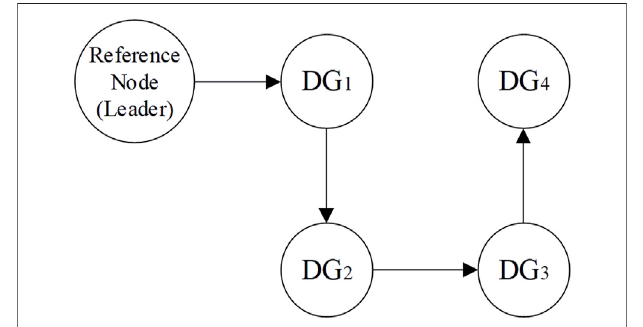
FIGURE 4 | Communication-directed